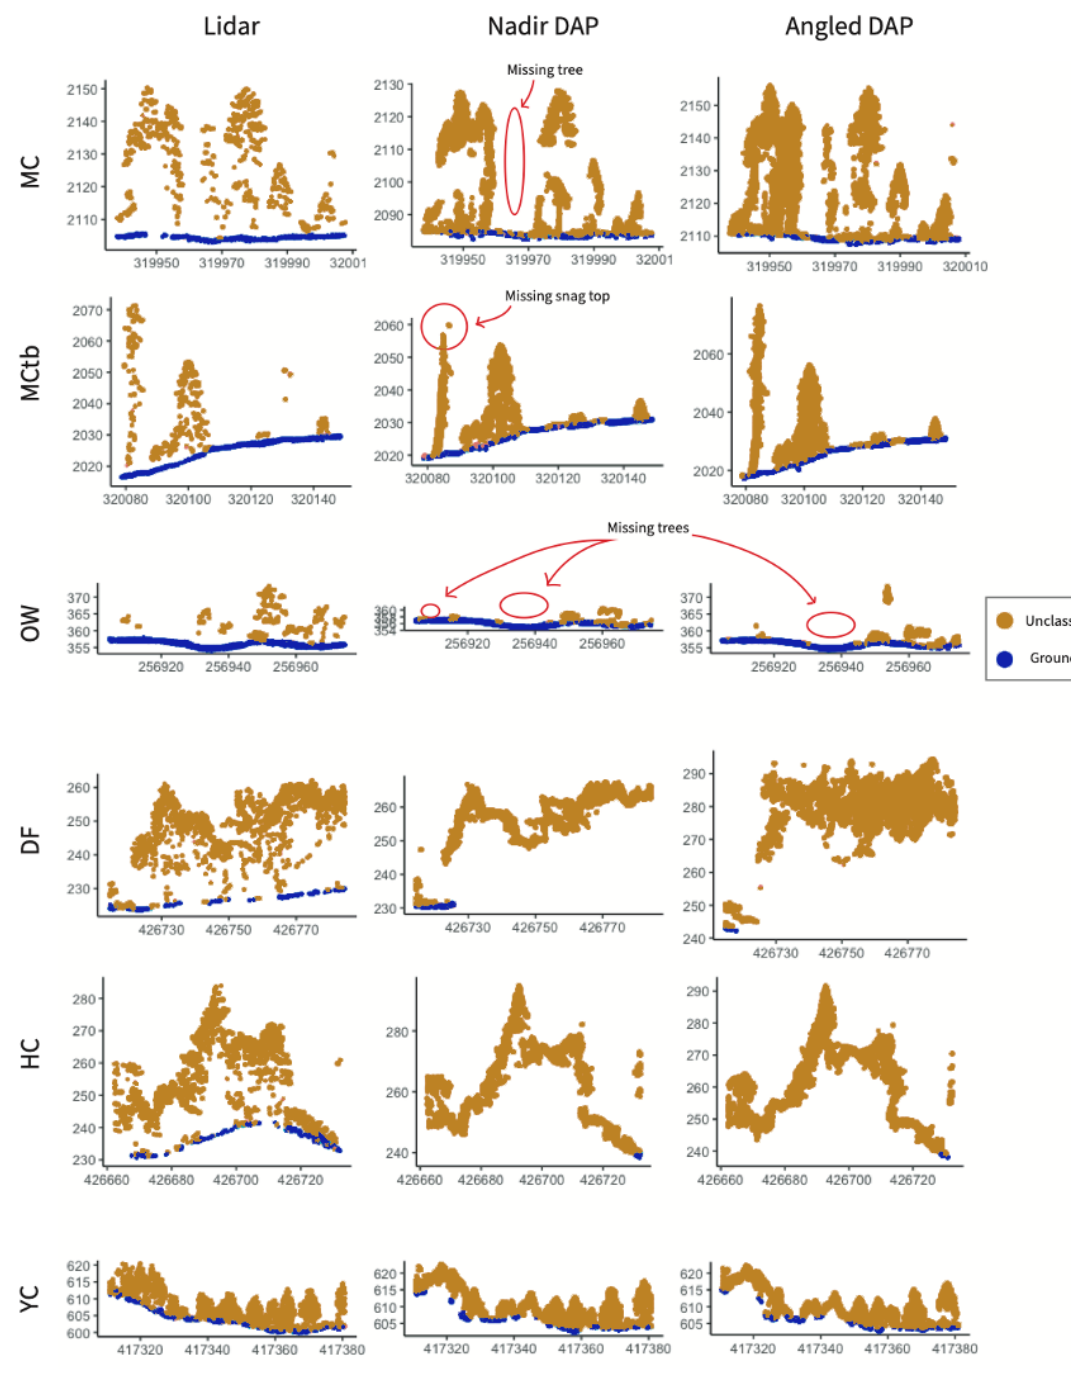
Figure 7. Point clouds from lidar, nadir DAP and angled DAP shown as 70 m transects for each site and colored by classification. The different sites are shown on the vertical axis with different model types on the horizontal axis. Arrows show missing canopy data or, in the case of MCtb, the missing top of a standing dead tree (snag).